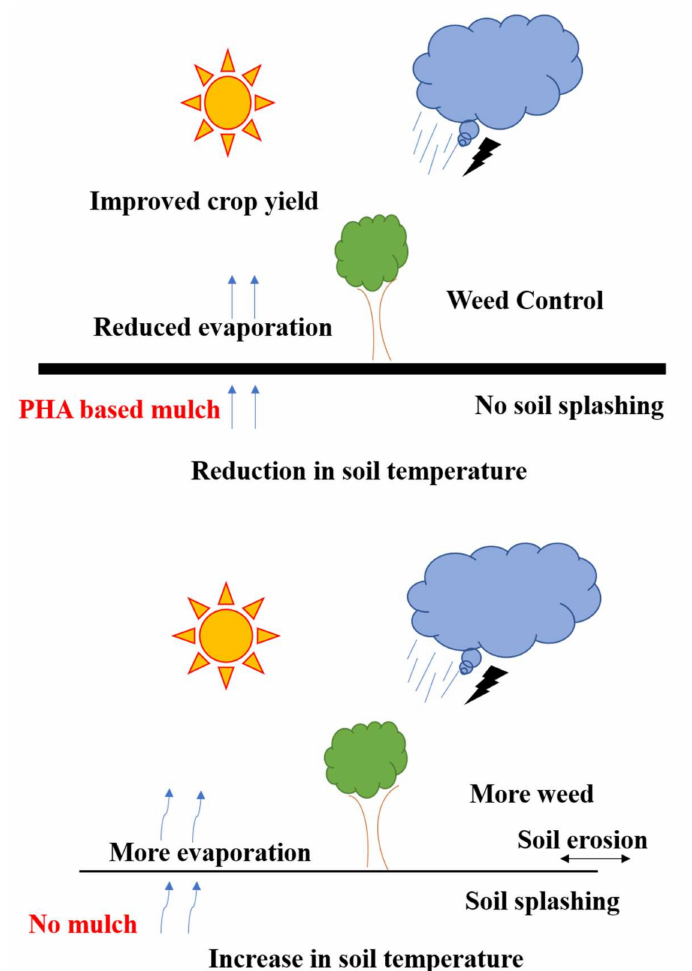
Figure 5. Effects of PHA-based mulching (Inspired from Sintim and Flury,